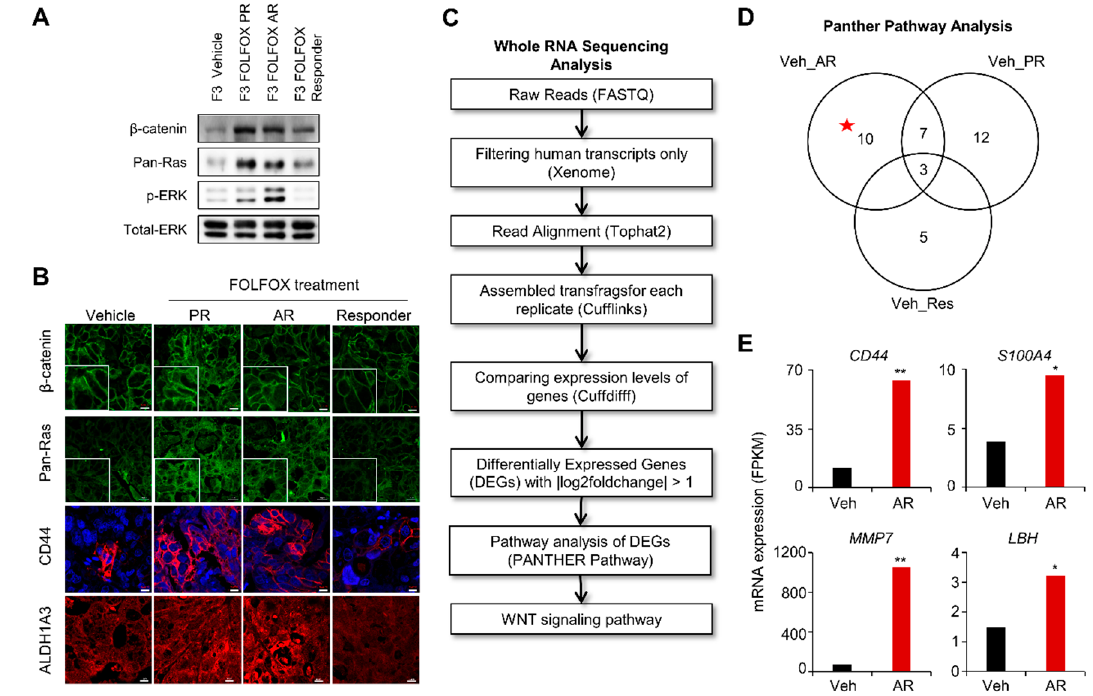
Figure 3. GC PDX tumors with acquired resistance to FOLFOX show increase of β -catenin and pan-Ras, and the activation of CSCs markers. ( A ) Immunoblot (IB) analyses using whole cell lysates (WCLs) of patient-derived xenograft (PDX) tumors treated with either vehicle or FOLFOX ( n = 9 vehicle, n = 3 Res, n = 3 PR, and n = 2 AR). Immunoblotting was performed using the indicated antibodies as described in the Methods section. ( B ) Formalin-fixed 4- μ m paraffin sections of the PDX tumors ( A ) were evaluated by immunohistochemical (IHC) analyses using anti- β -catenin, pan-Ras, CD44, or ALDH1A3 antibody. Nuclei were counterstained with4,6-diamidino-2-phenylindole (DAPI). Scale bar = 20 μ m. Images were captured using confocal microscopy (LSM700; Carl Zeiss). ( C ) Flow chart of whole RNA sequence analysis. After FOLFOX treatment, the mRNA of PDX tumors was extracted and the change in the gene expression level was analyzed. ( D ) Venn diagram of exclusively enriched pathways in FOLFOX-treated groups compared with the vehicle group. Differential pathway enrichment was identified using statistical overrepresentation test of PANTHER (Protein ANalysis THrough Evolutionary Relationships) pathway analysis (Gene Expression Omnibus (GEO) accession number: GSE128967). ( E ) RNA-seq–based gene expression values (FPKM) for CD44 , S100A4 , MMP7 , and LBH in vehicle and AR. Asterisks indicate statistically significant differences for gene expression in AR compared with vehicle. * q < 0.05, ** q < 0.005, *** q < 0.0005 versus control.